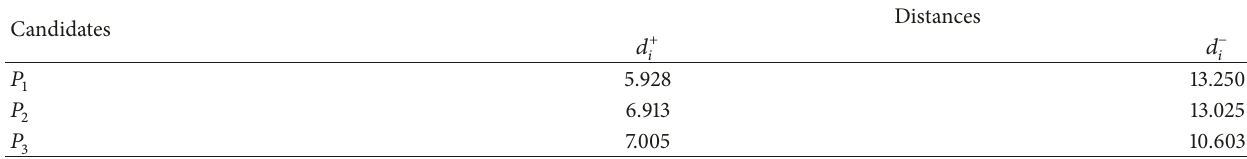
Table 9: The distances of the candidate joint venter contractors from the PIS and NIS.